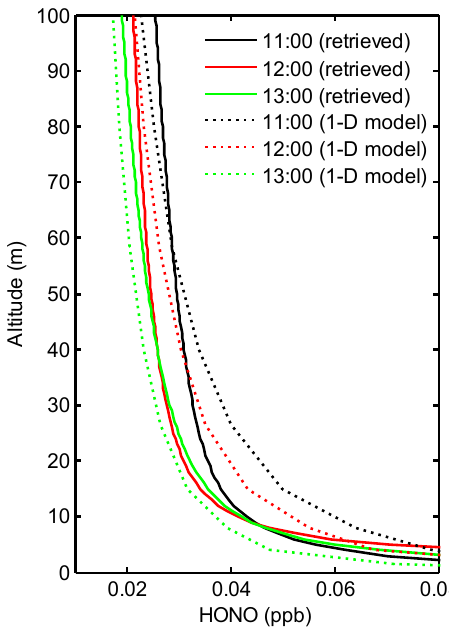
Figure 3. Hourly average of the vertical profiles of HONO retrieved using the least-squares fitting methodology (solid lines) for 7 Febru- ary 2012 near noontime. The profile shape shows good agreement with those from vertical mixing ratio profiles of HONO modeled using the 1-D chemistry and transport model (dotted